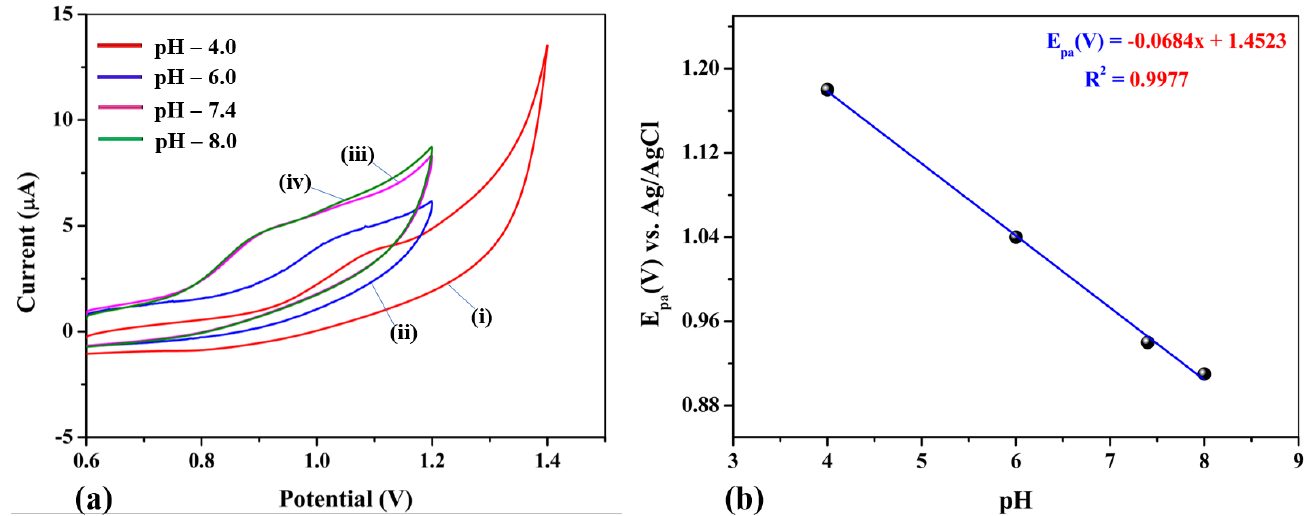
Figure 11. ( a ) CVs of Ag − NPs modified GCE were recorded in different pH solutions containing 150 µ M of NIC (pH 4 (i), pH 6 (ii), pH 7.4 (iii), and pH 8 (iv)) at a scan rate of 50 mV/s. ( b ) The correlation between various pH and oxidation potential of NIC .